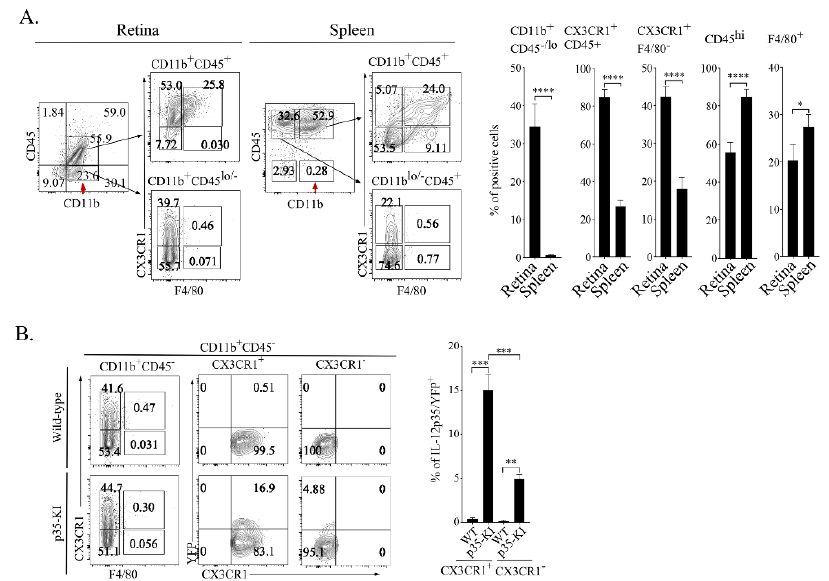
Figure 2. Retinal microglia constitutively express IL-35. ( A ) Characterization of microglial cells in the retina and spleen by FACS analysis. Cells were gated using monoclonal antibodies specific to mouse CD45, CD11b and Cx3CR1. Representative flow cytometry plots showing percent CD11b + CD45 − /lo , Cx3CR1 + CD45 + , Cx3CR1 + F4/80 − , CD45 hi and F4/80 + cells ( left panels ) and bar graphs show percentage of exhibiting these immunophenotypes in the retina or spleen (right panels). ( B ) Single cell preparations of cells isolated from the retina of WT or p35-KI mice were analyzed and gated for CD45 lo (myeloid cells) and cells expressing YFP and p35. Numbers in quadrants represent